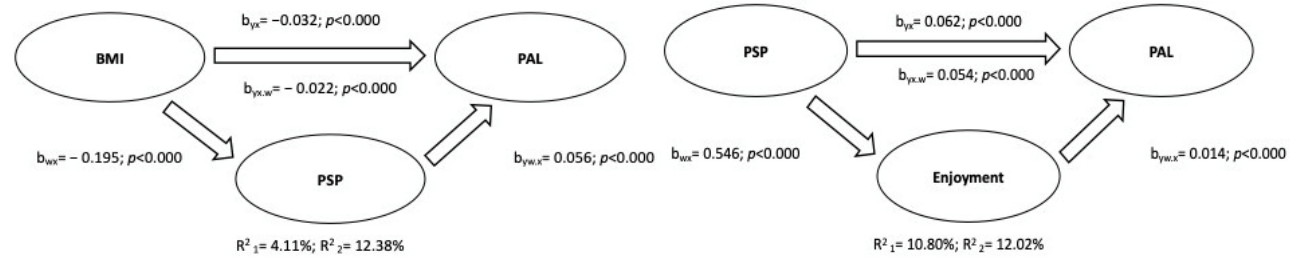
Figure 5. Mediation Analysis of Female Sample.